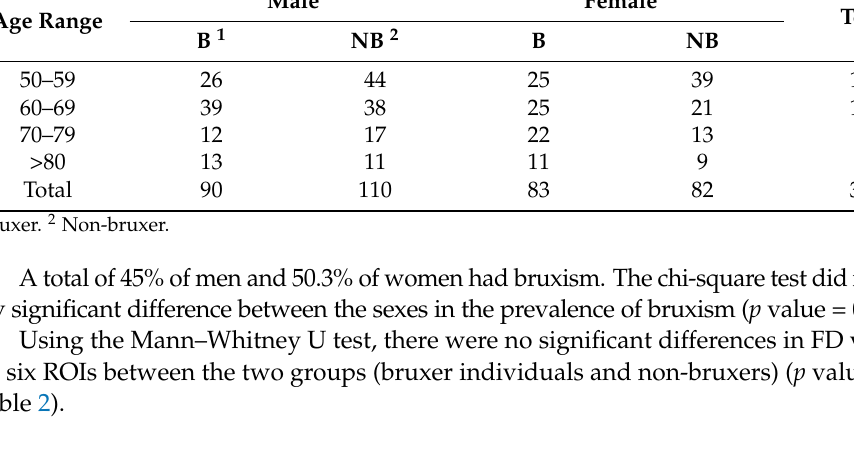
Table 2. FD values of different ROIs in the study groups. ROI Group